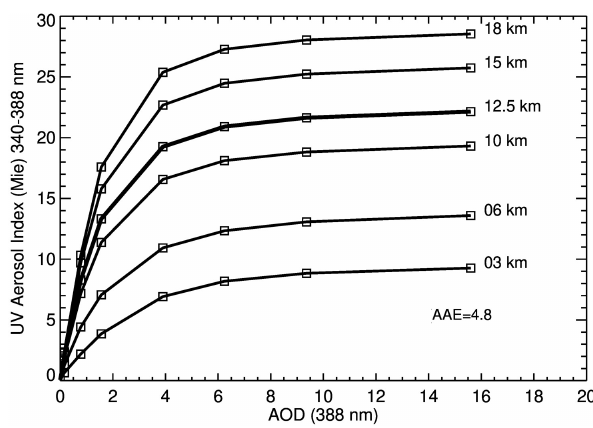
Figure 1. Modeled relationship between UVAI and AOD as a func- tion of ALH for carbonaceous aerosols with an assumed 340– 388nm aerosol absorption exponent of 4.8 (see text for